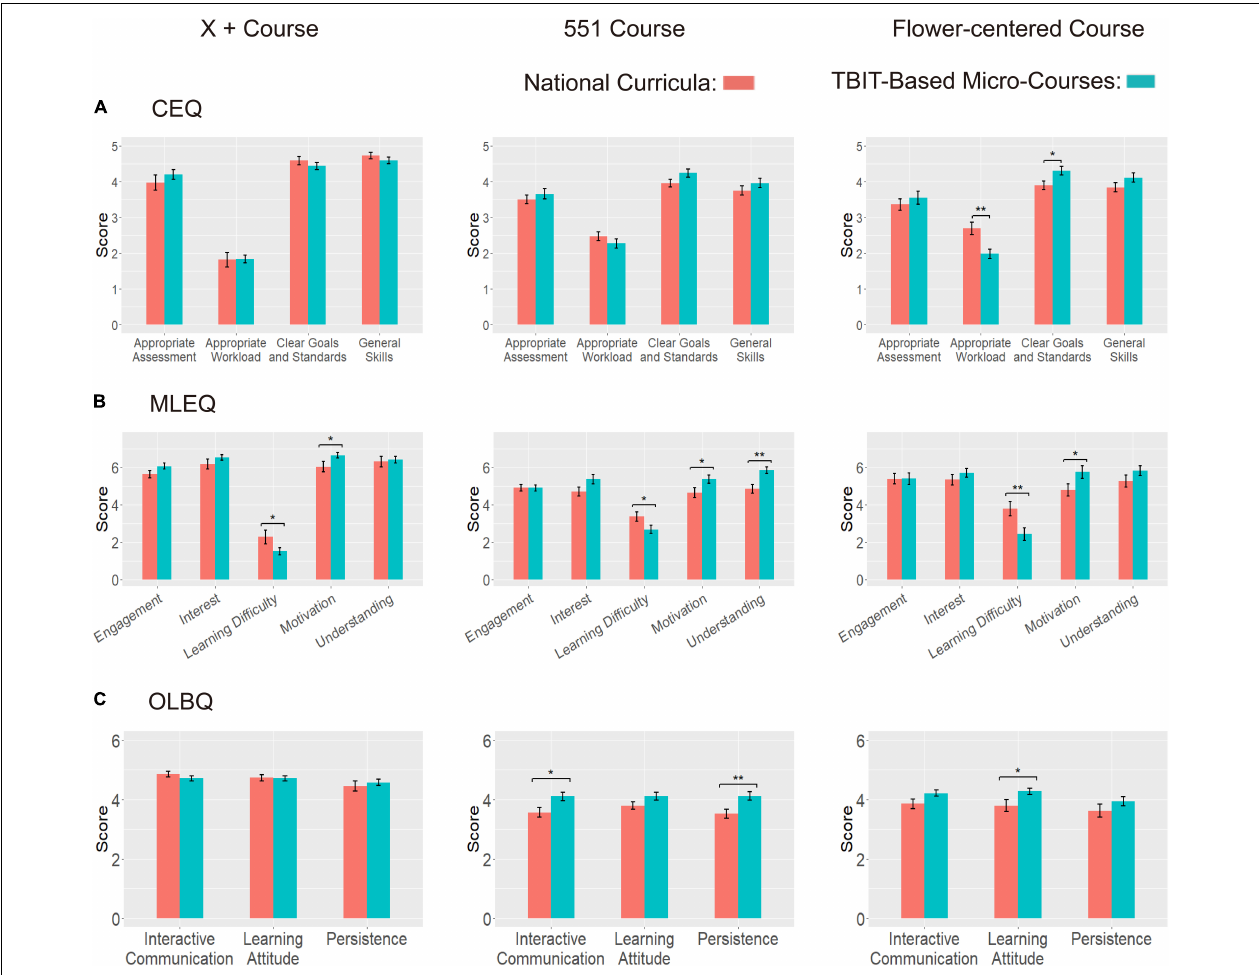
FIGURE 4 | The score of the two kinds of assessment of three questionnaires on three courses. (A) Course Experience Questionnaire, CEQ; (B) Mayer Learning Experience Questionnaire, MLEQ; (C) Online Learning Behavior Questionnaire,